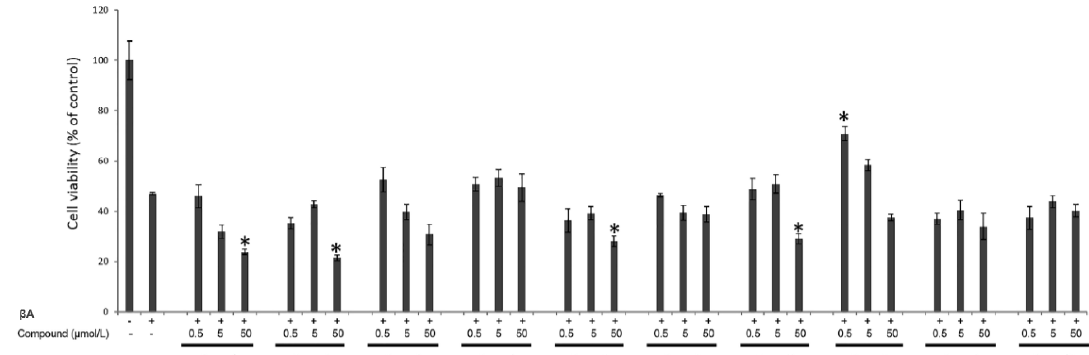
Figure 4. Effect of compounds 1 – 10 on PC12 cell viability. PC12 cells were incubated with compounds 1 – 10 (0, 5 and 50 µ M) for 24 h, and then exposure to 5 µ M of β A for 24 h. Data are expressed as mean ± SD ( n = 4). * p < 0.05 as compared to the β A treated